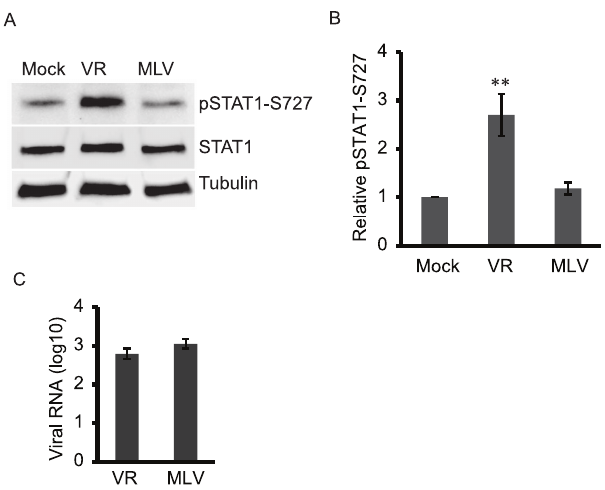
Figure 1. PRRSV VR-2385 induces elevation of phosphorylated STAT1 at serine 727 (pSTAT1-S727) in MARC-145 cells. A. VR- 2385 (VR) induces higher level of pSTAT1-S727 in MARC-145 cells than MLV. The infected cells were harvested at 24 hpi for Western blotting with antibodies against pSTAT1-S727, STAT1 and tubulin. Lysate of mock-infected cells was included as a control. B. Densitometry analysis of pSTAT1-S727 bands to show relative level of pSTAT1 in comparison with mock-infected cells as folds after normalization with tubulin. Significant difference from mock-infected control is shown by ‘‘**’’, which indicates P , 0.01. Errors bars indicate standard errors of repeated experiments. C. PRRSV viral RNA copies in the PRRSV-infected cells detected by real-time RT-qPCR and shown as log10 per 10 ng total